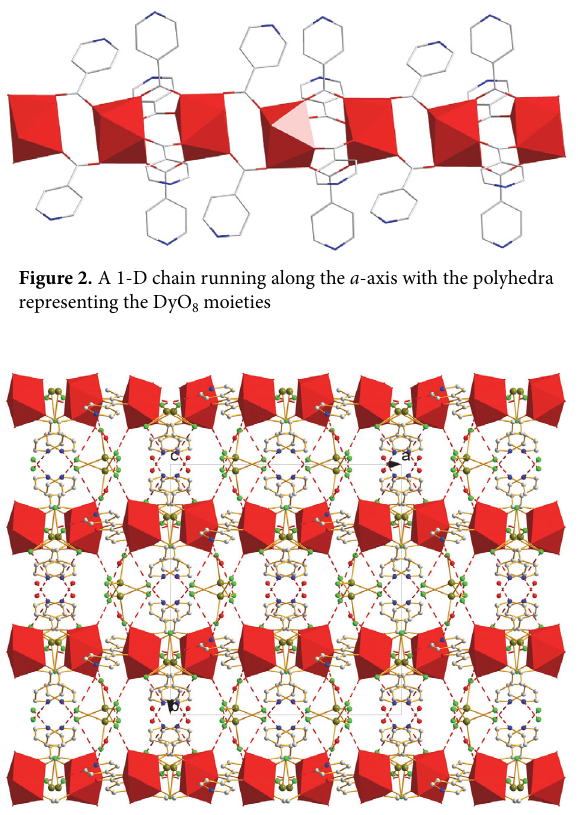
Figure 3. A packing view of 1 with the polyhedra representing the DyO 8 moieties. The dashed lines are hydrogen bonding interactions (see Table 3,